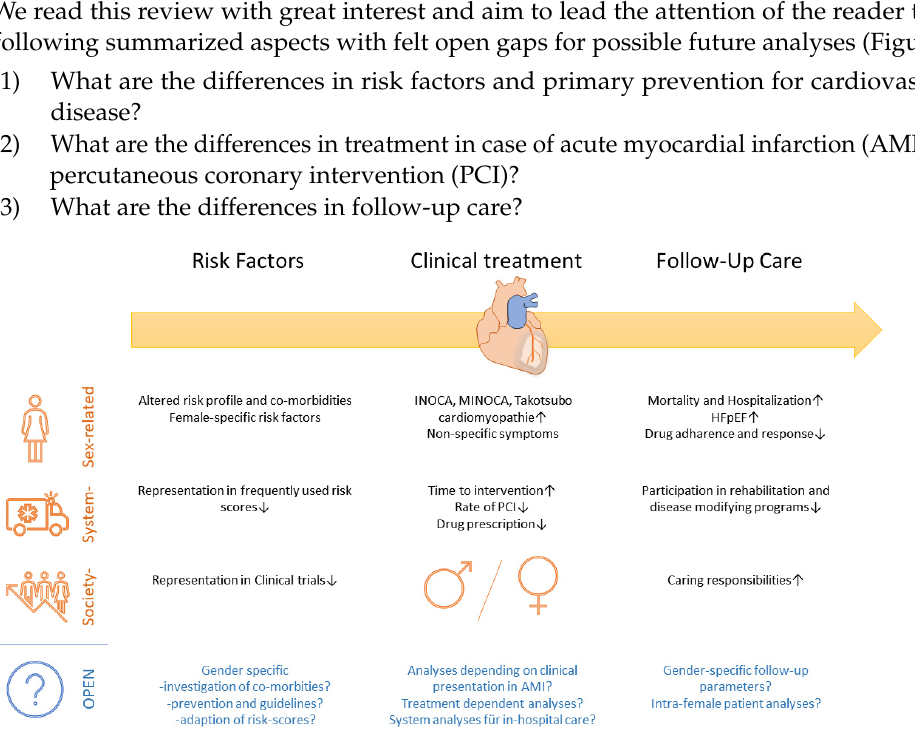
Figure 1. Adapted summarized aspects for gender-specific differences in cardiovascular disease [1], depending on risk factors, clinical treatment, and follow-up care complemented by relevant open questions and